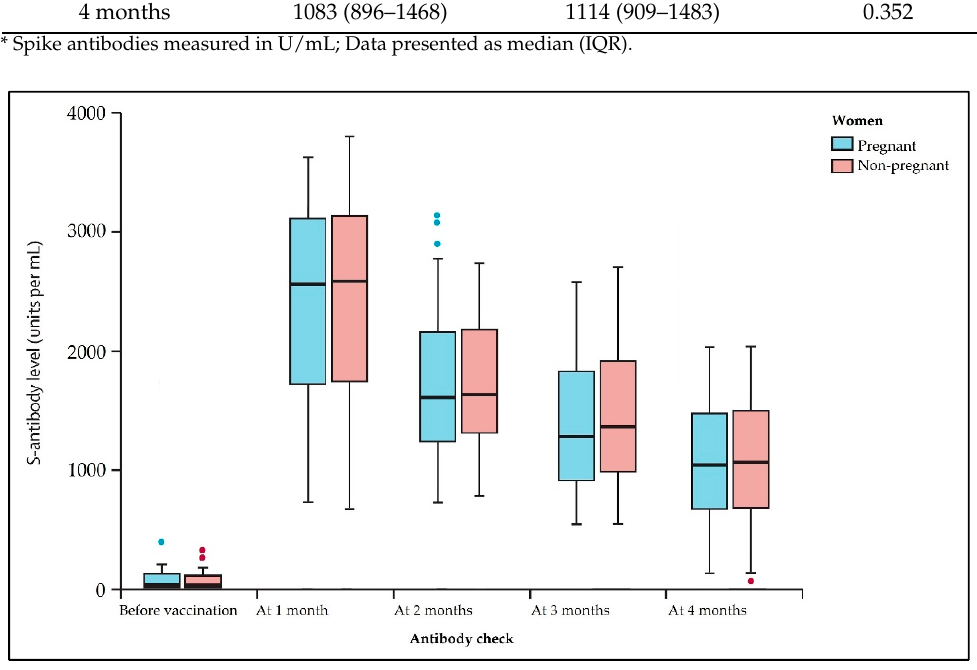
Figure 3. Boxplot comparison of pregnant vs. non-pregnant patients’ spike antibodies. Data was evaluated in a seriated fashion, being followed before vaccination every month until 4 months. Median values and interquartile range are represented inside the box; minimum, maximum, and outliers are shown outside the box. Table 5. Case-matched comparison of pregnant vs. non-pregnant patients’ adverse effects after receiving the COVID-19